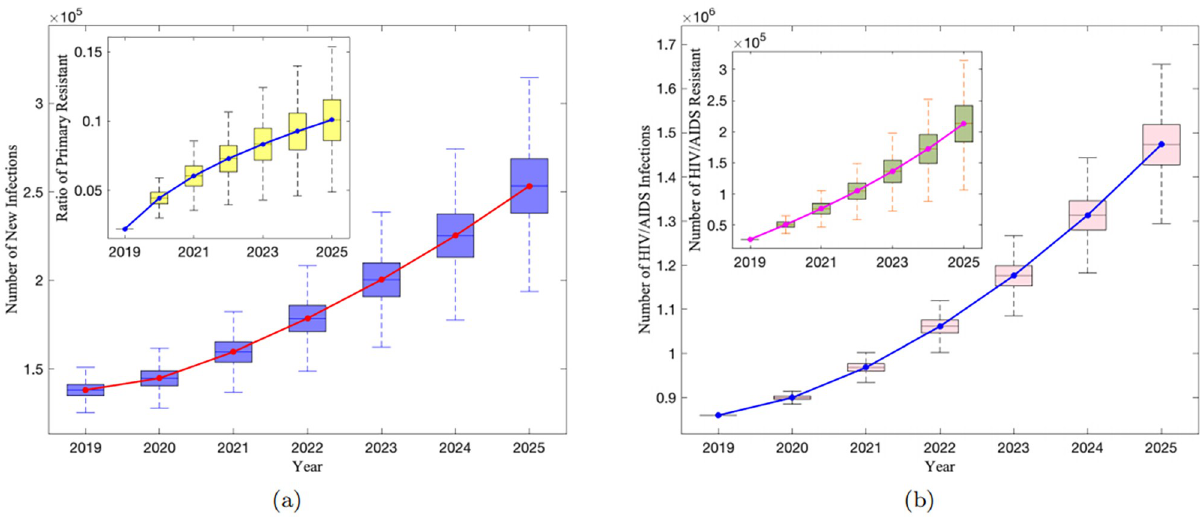
Fig 3. HIV/AIDS infection and drug resistance of heterosexuals under baseline parameters in China. a: The new infections and primary resistant rate. b: The total of HIV/AIDS infections and the total of HIV resistance.